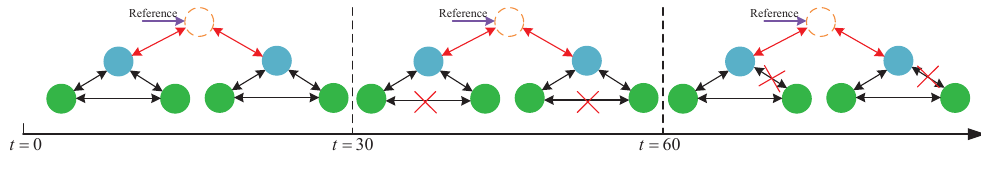
Figure 12. Communication failure among BESSs.